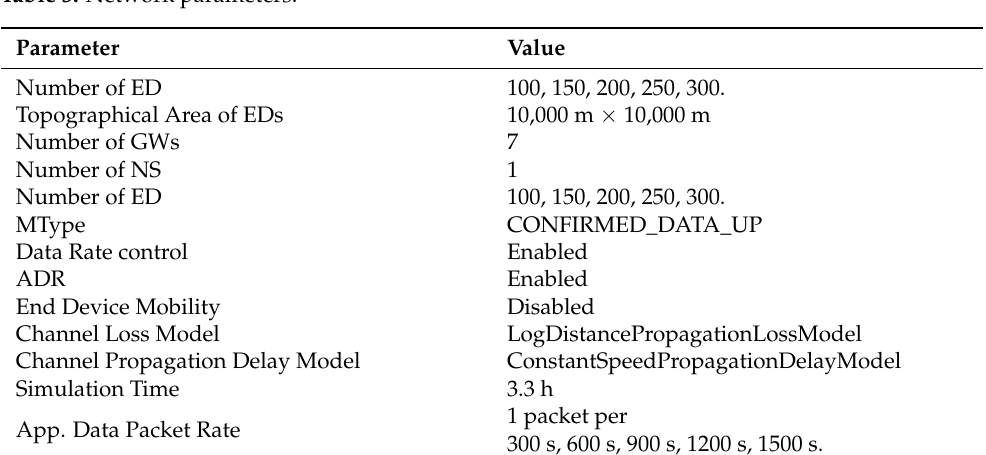
Table 3. Network parameters.